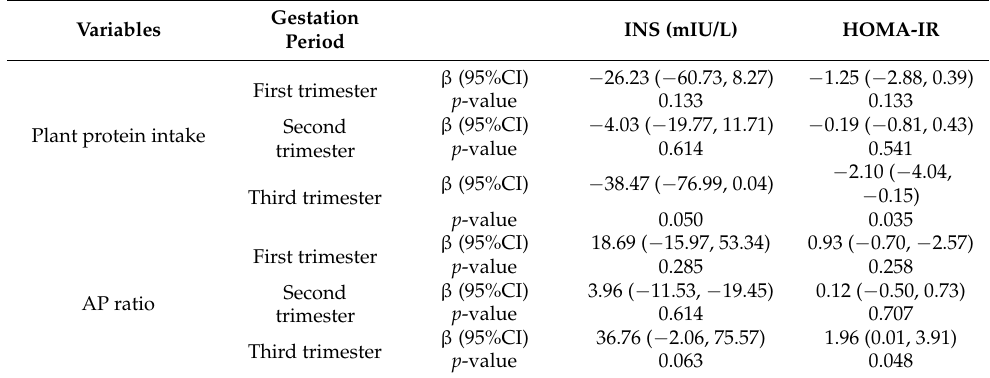
Table 5. The multiple linear regression results of plant protein intake, AP ratio, and INS or HOMA-IR after stratification by gestation period a .